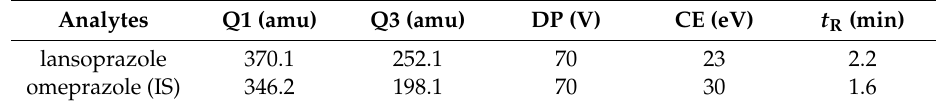
Optimized multiple-reaction-monitoring (MRM) parameters for lansoprazole and omeprazole